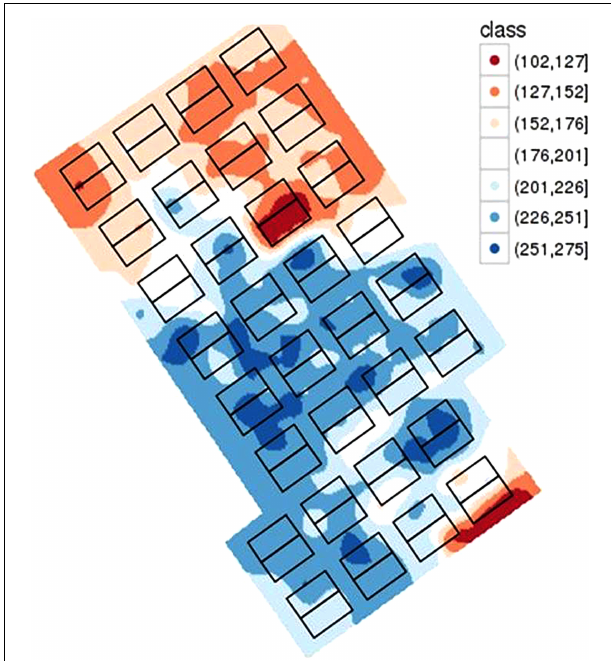
FIGURE 6 | Characterization of the soil water holding capacity (mm) on the PhénoField R (cid:13) platform with rectangles representing a span in each of the eight shelters and for the four positions.